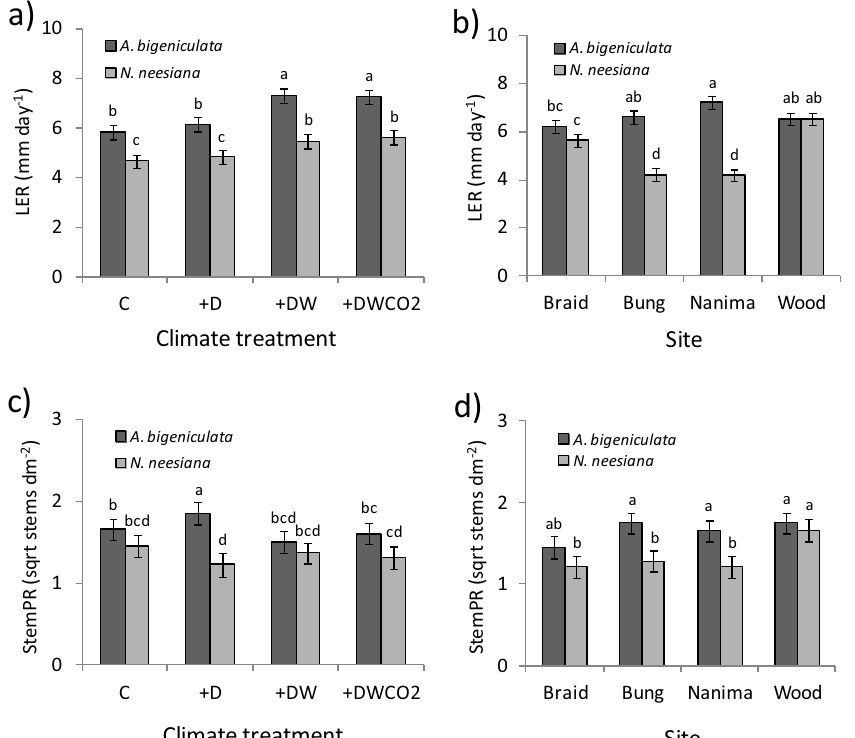
Figure 7. Growth of A. bigeniculata and N. neesiana during Phase III of the experiment. ( a ) Leaf elongation (LER) across climate treatments during August 2011. ( b ) LER across study populations during August 2011. ( c ) Stem production (StemPR) across climate treatments in November 2011. ( d ) StemPR across study populations in November